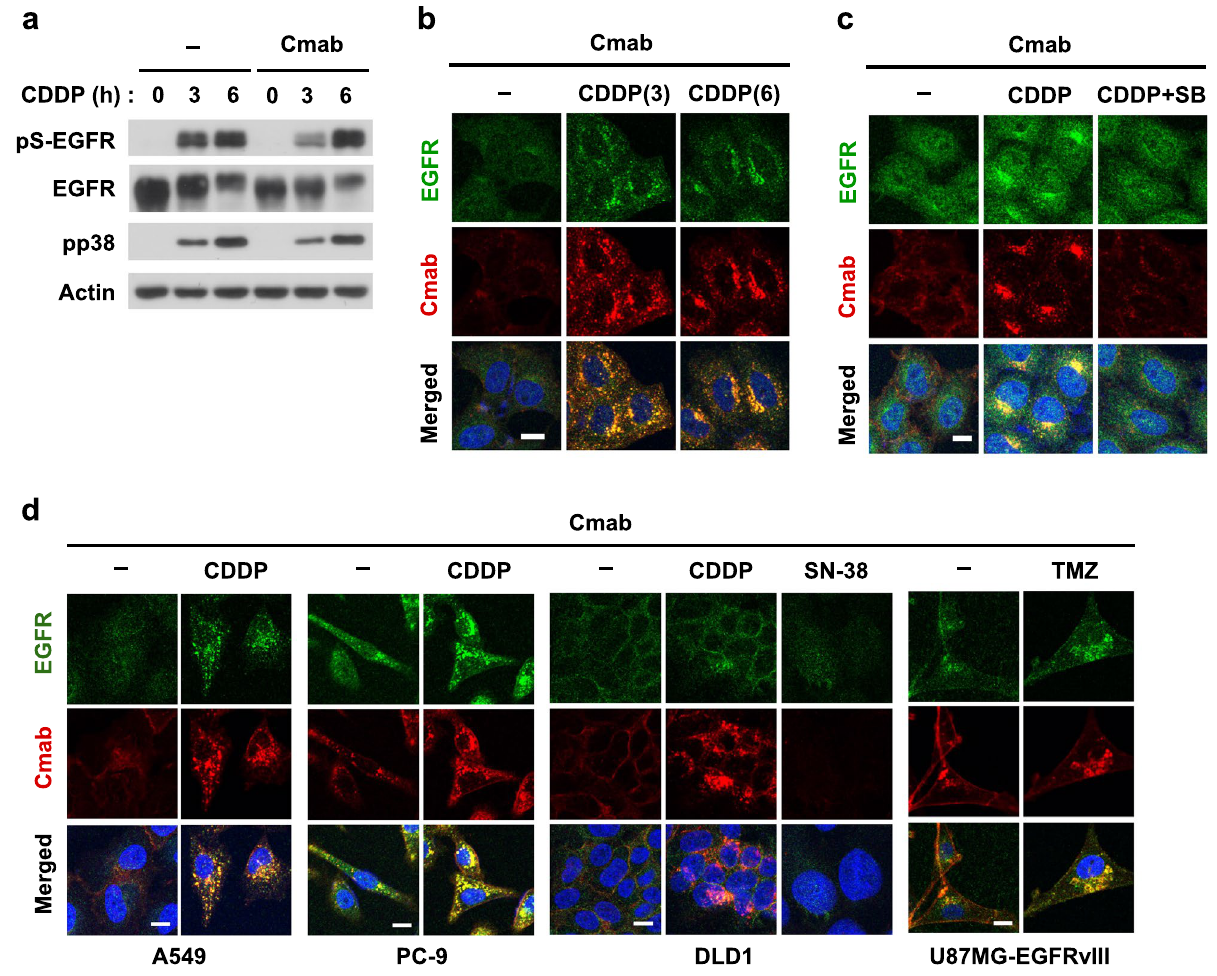
Figure 6. Sustained internalization of anti-EGFR antibodies by cisplatin. ( a , b ) HeLa cells were pretreated with 100 nM cetuximab for 10 min and then stimulated with 100 µM cisplatin (CDDP) for 3 or 6 h. The expression of phospho-p38 and pS-EGFR was examined by immunoblotting ( a ). The intracellular expression of EGFR and cetuximab was investigated by immunofluorescence ( b ). Original blots are published in Supplementary Fig. S3. ( c ) HeLa cells were pretreated with 10 µM SB203580 for 30 min, treated with 100 nM cetuximab for 10 min, and then stimulated with 100 µM CDDP for 6 h. The intracellular expression of EGFR and cetuximab was investigated by immunofluorescence. ( d ) A549, PC-9, DLD1, and U87MG-EGFRvIII cells were pretreated with 100 nM cetuximab for 10 min and then stimulated with 100 µM CDDP for 6 h, 1 µM SN-38 for 48 h, or 100 µM temozolomide (TMZ) for 48 h. Intracellular EGFR and cetuximab were visualized by immunofluorescence. Scale bar = 10